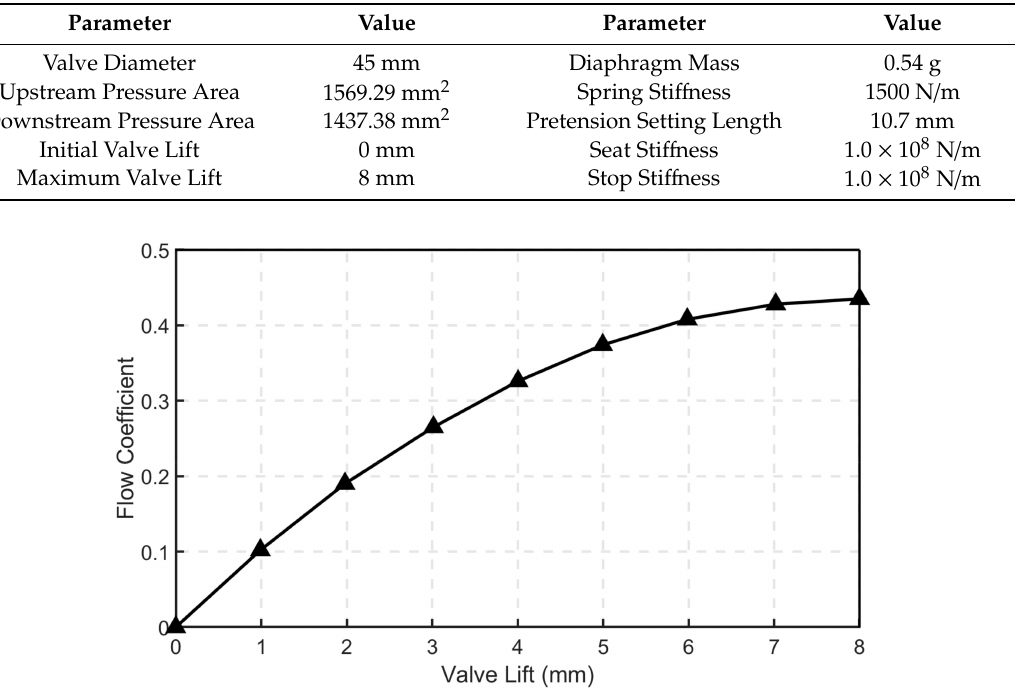
Table 6. Parameter settings of reed valve.